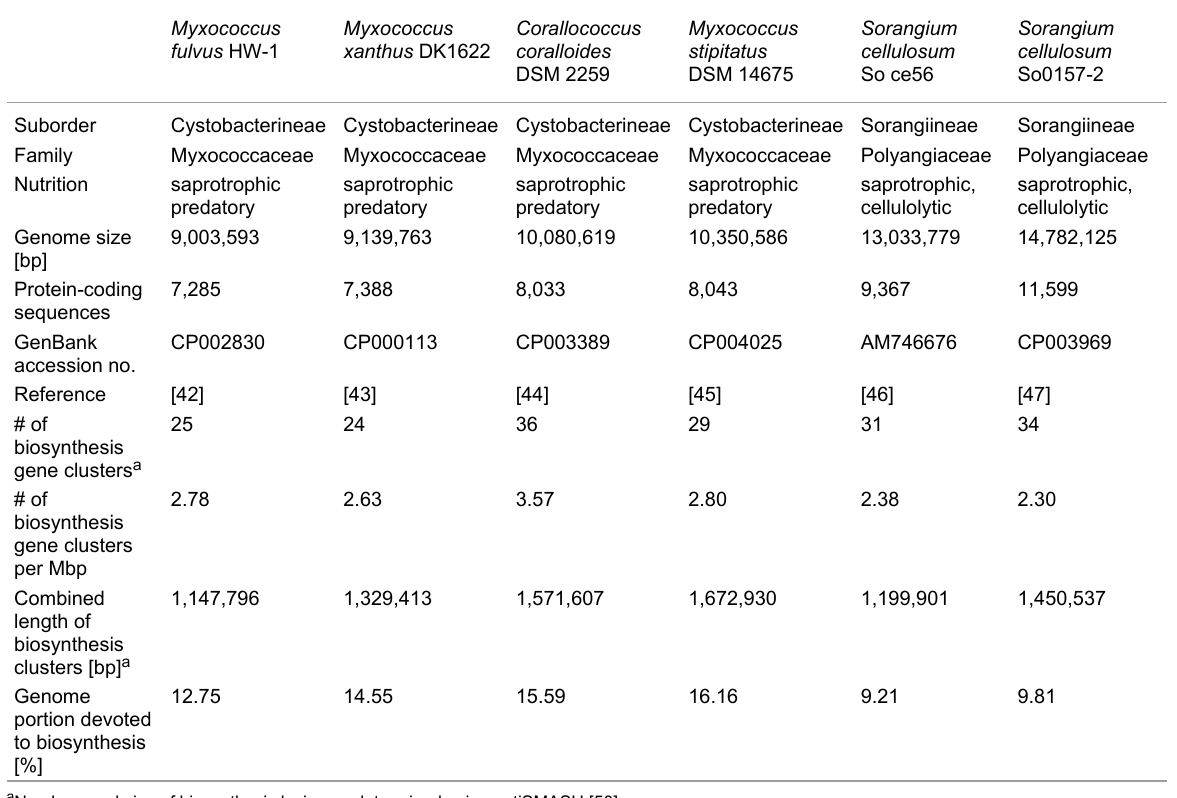
Table 1: Taxonomic assignment, nutrition, genomic and biosynthetic features of myxobacterial